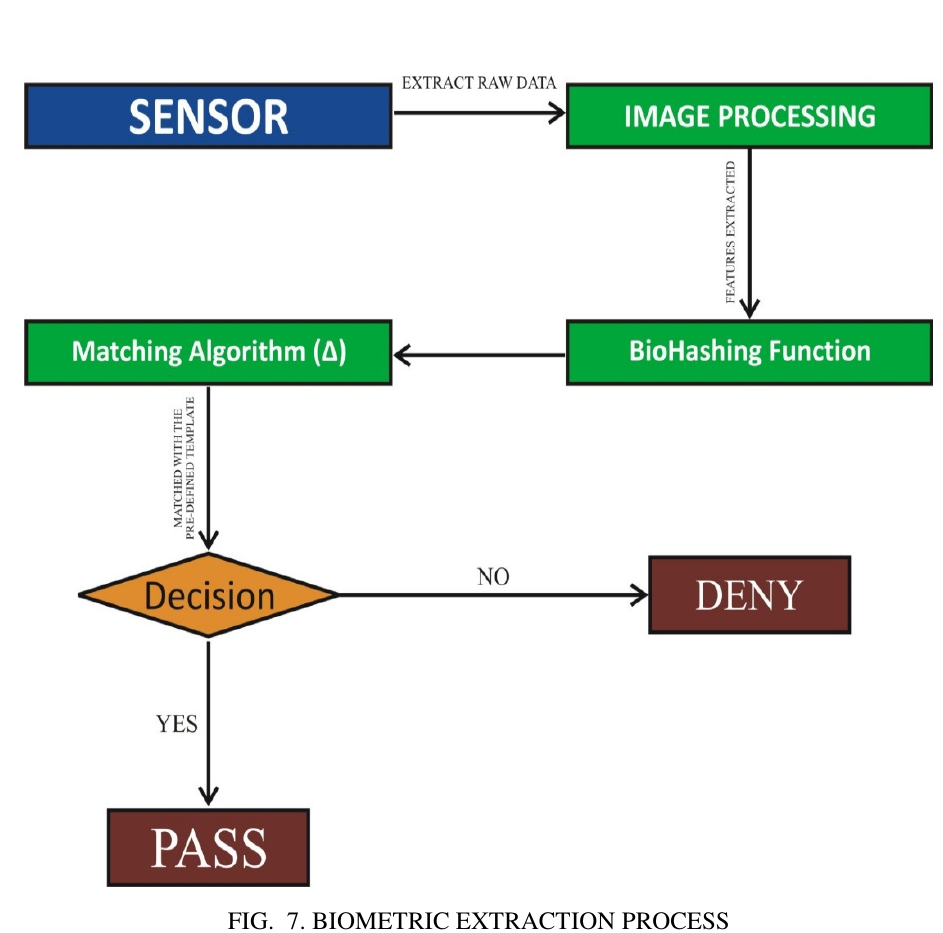
FIG. 7. BIOMETRIC EXTRACTION